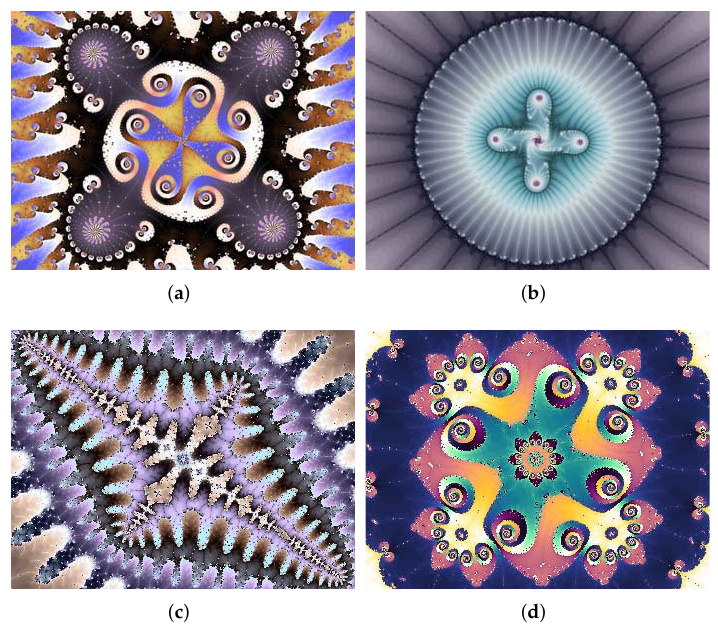
Figure 23. ( a – d ) Ultra-deep details from within the Mandelbrot set. Images range from a depth of 10 74 magnification to deeper than 10 245 power. Images source: Fractal Foundation, available at https://fractalfoundation.org/OFC/OFC-3-1.html (accessed on 20 October